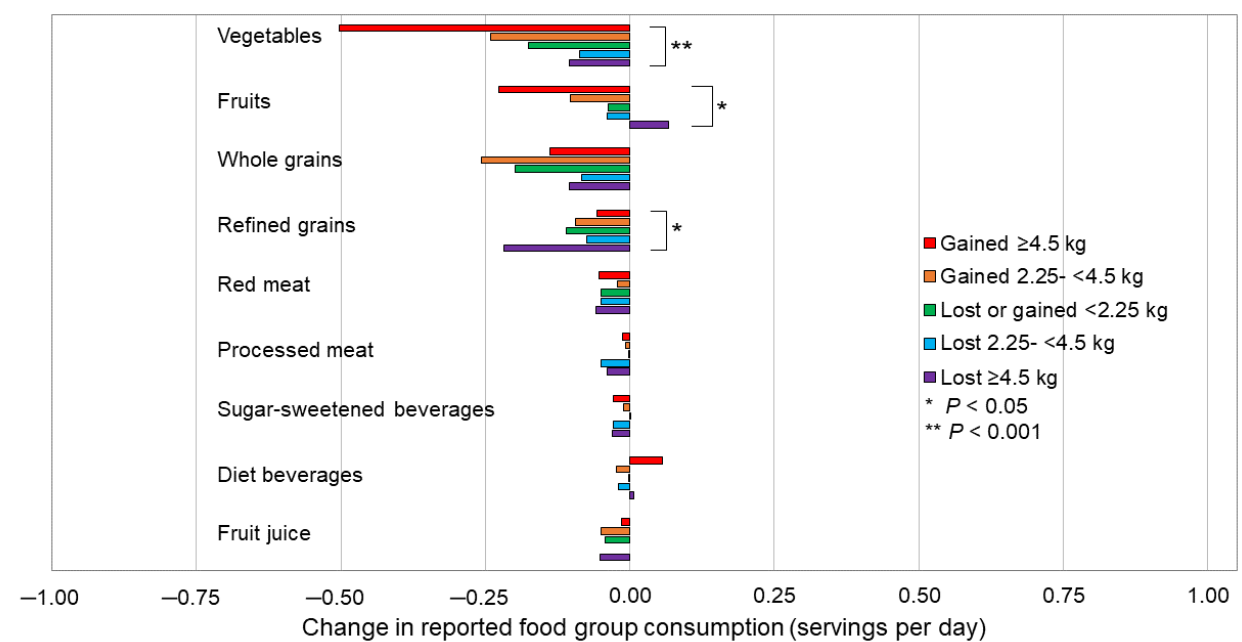
Figure 2. Mean change in individual food group consumption (servings per day) from before (2018) to during (July/Aug 2020) the COVID-19 pandemic among a subgroup of Cancer Prevention Study-3 cohort participants, stratified by weight change categories (N = 2335). p -values between strata were examined by ANOVA and are presented using an asterisk for p < 0.05 and two asterisks for p < 0.001.